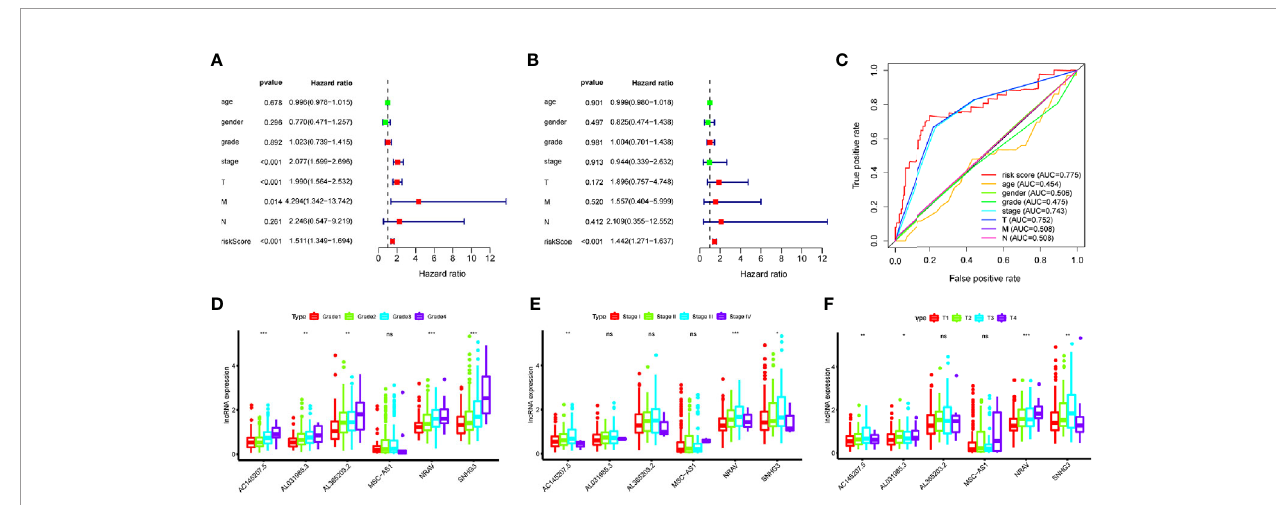
FIGURE 3 | Evaluation of immune-related lncRNAs as independent prognostic factors in HCC. (A, B) Univariate and multivariate Cox regression analysis of age, gender, grade, stage, TMN stage and risk score. (C) The AUC for age, gender, grade, stage, TMN stage and risk score. (D – F) LncRNA expression increased with grade, tumor-stage and T-stage. ns p > 0.05, *p < 0.05, **p < 0.01, ***p <